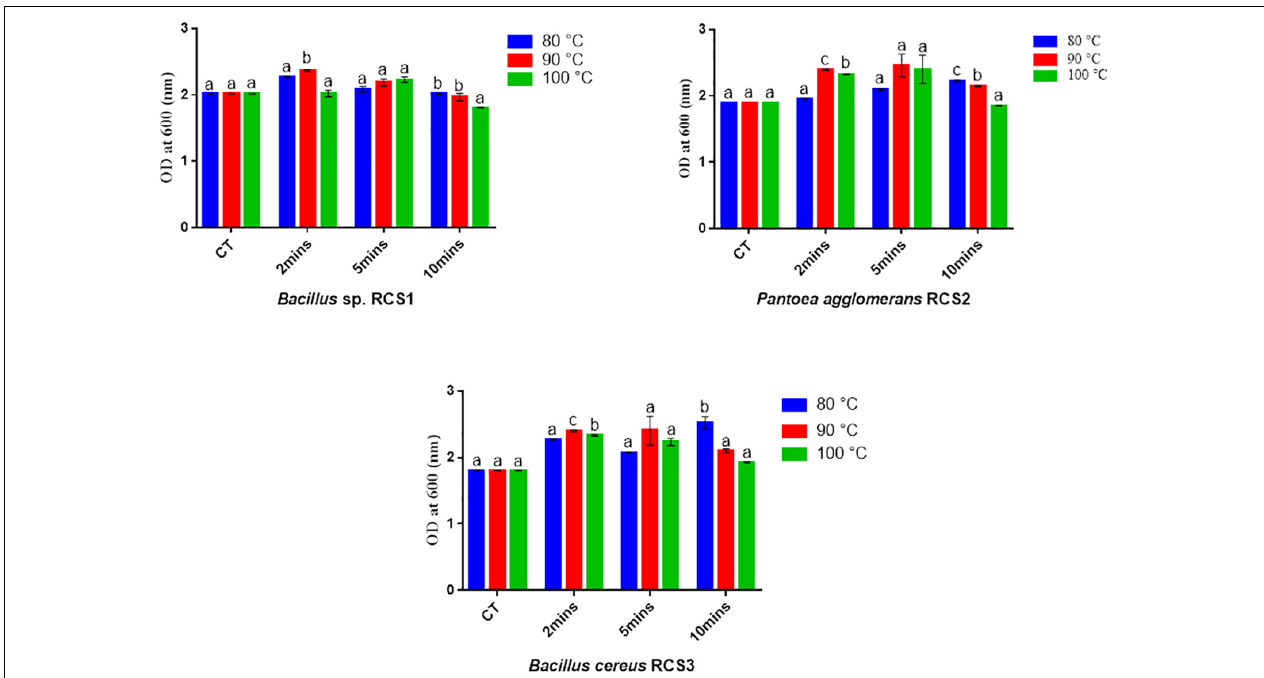
FIGURE 4 | Bacterial endurance to high temperatures. Values are presented as mean ± SE. Different letters show significant differences ( P < 0.05). CT indicates control.